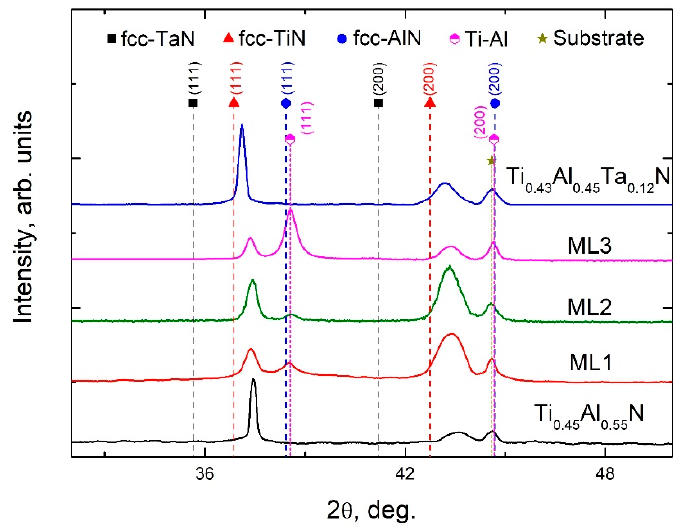
Figure 1. XRD patterns of the Ti 0.45 Al 0.55 N and Ti 0.43 Al 0.45 Ta 0.12 N monolithic coatings, and Ti 0.45 Al 0.55 N/Ti 0.45 Al 0.55 multilayers. Ti 0.45 Al 0.55 N/Ti 0.45 Al 0.55